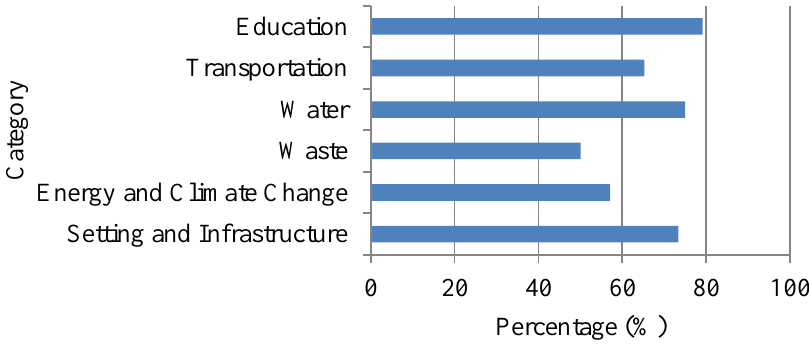
Figure 1. Green metric performance of Erciyes